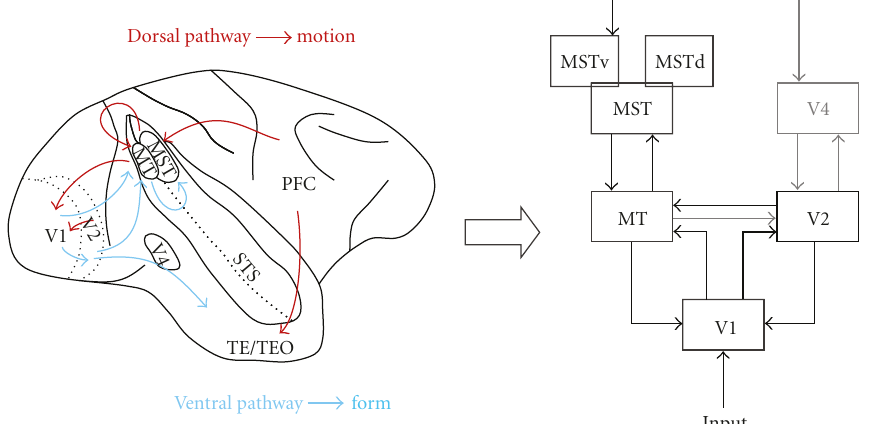
Figure 1: Structure of the organization of the visual cortical architecture with its areas and interconnections. The entry stage for cortical visual processing is in area V1, the primary visual cortex. Feature processing along ascending pathways (blue arrows) proceeds along two roughly segregated pathways, namely, the dorsal and the ventral pathway, respectively. While the processing along the ventral path is mostly devoted to shape and form (WHAT system), the dorsal path is mostly concerned with motion processing (WHERE system). Areas higher up in the hierarchy send feedback connections along descending pathways (red arrows) to influence the activation distributions at earlier stages in the hierarchy. The scheme of interactive processing between di ff erent areas has been sketched on the right in a box-and-arrow scheme. The di ff erent arrows indicate the signal flow between the di ff erent boxes, namely, areas, in the layout. Several cortical areas are highlighted here to allow an association with major cortical areas and also the cross-reference between the brain sketch on the left and the box picture on the right (V1: primary visual cortex; MT: medial temporal; MST: medial superior temporal (with v and d denoting the ventral and dorsal subdivisions, resp.); PFC: prefrontal cortex; V2: secondary visual area; V4: visual area 4; TE/TEO: areas in inferior temporal cortex; STS: superior temporal